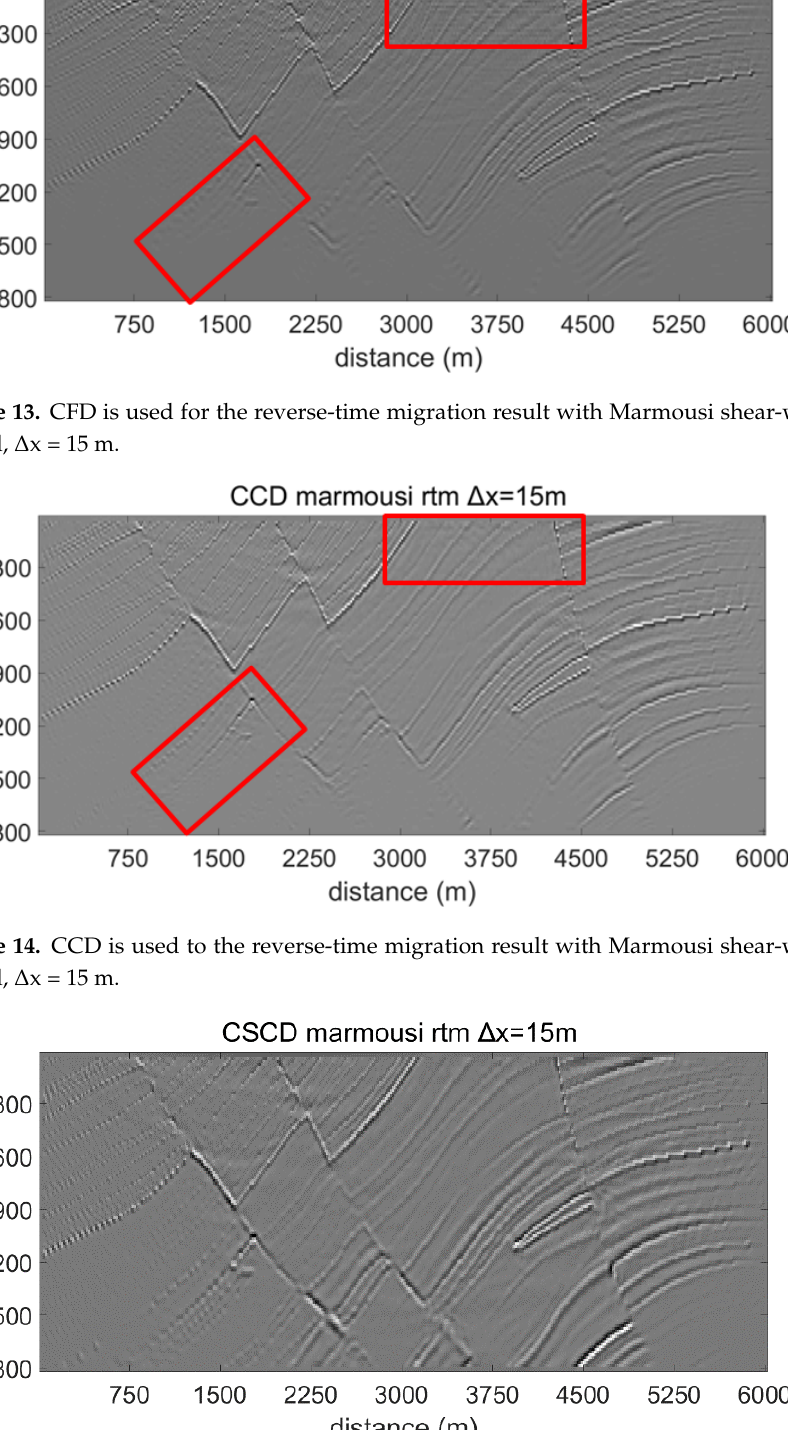
Figure 15. CSCD is used for the reverse-time migration result with Marmousi shear-wave velocity model, Δ x = 15 m.